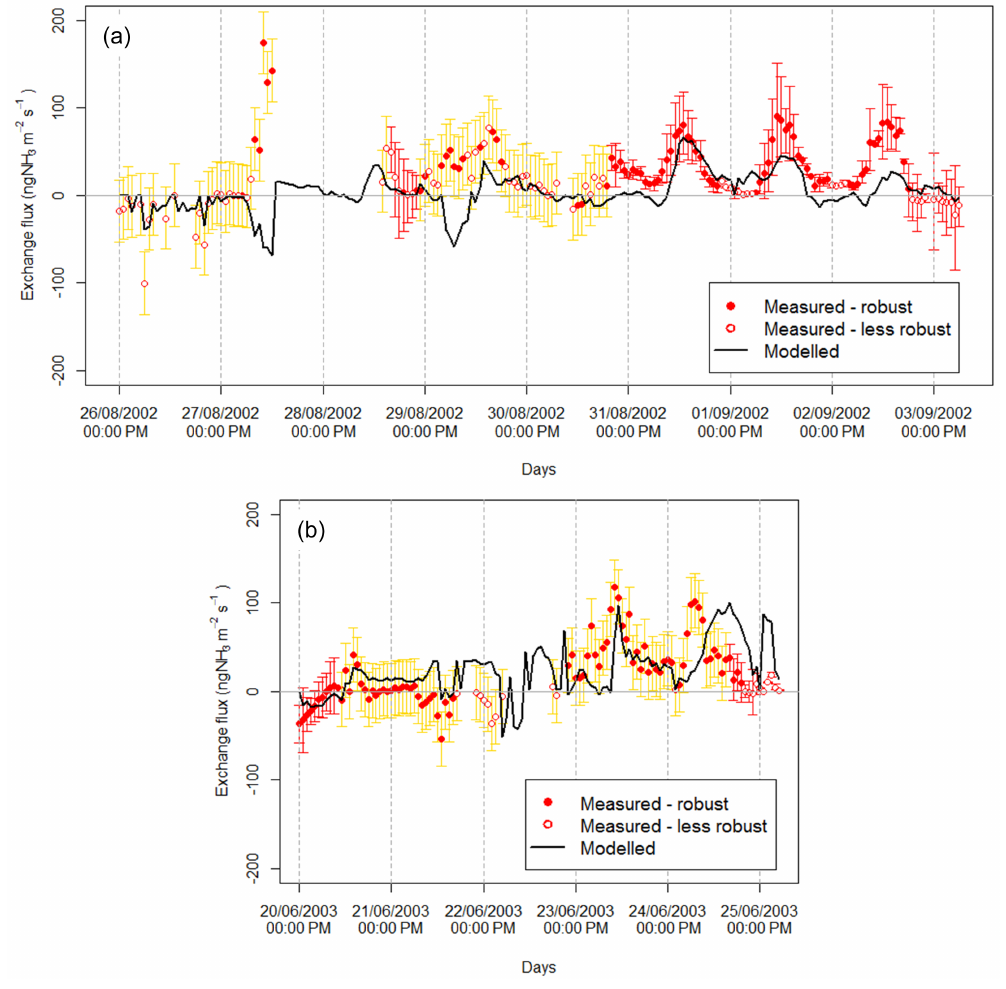
Figure 9. Comparison of the measured and modelled NH 3 fluxes in the modelling periods P2002 (a) and P2003 (b) . The uncertainty of the flux measurements is depicted as error bars. Yellow error bars indicate the cases where one of the three NH 3 concentration denuders were malfunctioning or not registering data at all. For these, the error was estimated as the average of the observed errors (red error bars) multiplied by an arbitrary factor of 2. A measured flux was considered to be robust if it met the criteria of the quality control for low wind speed and strong stability as described in Sect.